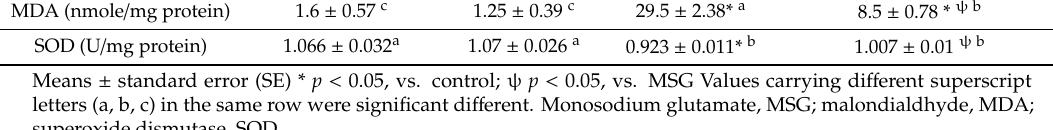
Table 2. E ff ects of monosodium glutamate and / or Allium sativum powder on malondialdehyde (MDA) concentration and superoxide dismutase (SOD) activity in brain tissue. Control Allium sativum MSG Allium sativum -Treated MSG MDA (nmole / mg